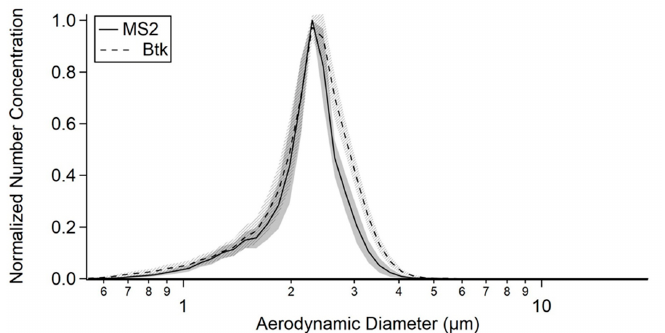
Figure 2. Normalized aerosol size distribution for MS2 (solid line) and Btk (dashed line) aerosol disseminated in this study. Shaded areas represent the standard deviation at each size. The means for Btk were calculated from experiments carried out on 3 and 4 October 2012, while the means for MS2 were calculated from experiments carried out on 15, 17 and 18 October 2012. Four experiments were conducted with Btk , in which dispersed fluorescence spectra from single Btk particles were collected along with ambient environmental data from local instruments and regional air-quality-monitoring stations. During this period, only a sub- set of the ambient data was available (temp, RH, NO y , NO, O 3 , solar radiation, and UVB intensity). Fluorescence spectra were collected at regular intervals (approximately hourly) to examine their changes in the spectral profiles and intensities due to atmospheric aging of the particles over time. Representative spectra from the experiments performed on 4 October 2012 (Figure 3 a,b) demonstrate a marked reduction in the fluorescence intensity across the entire range of measured emission wavelengths for both excitation wavelengths